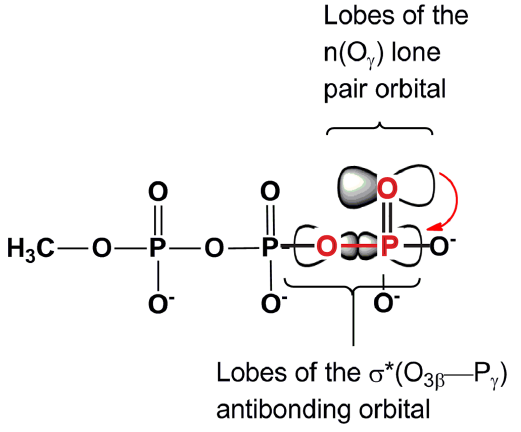
Figure 6. The O 3 b —P c bond length and hyperconjugation increase with decreasing D NNN O 3 b hydrogen bond length in Structure1. Calculated E(2) energy is of the n(O c ) R s *(O 3 b —P c ) hyperconjugative interaction. D is the N—H hydrogen bond donor in N-methylacetamide.